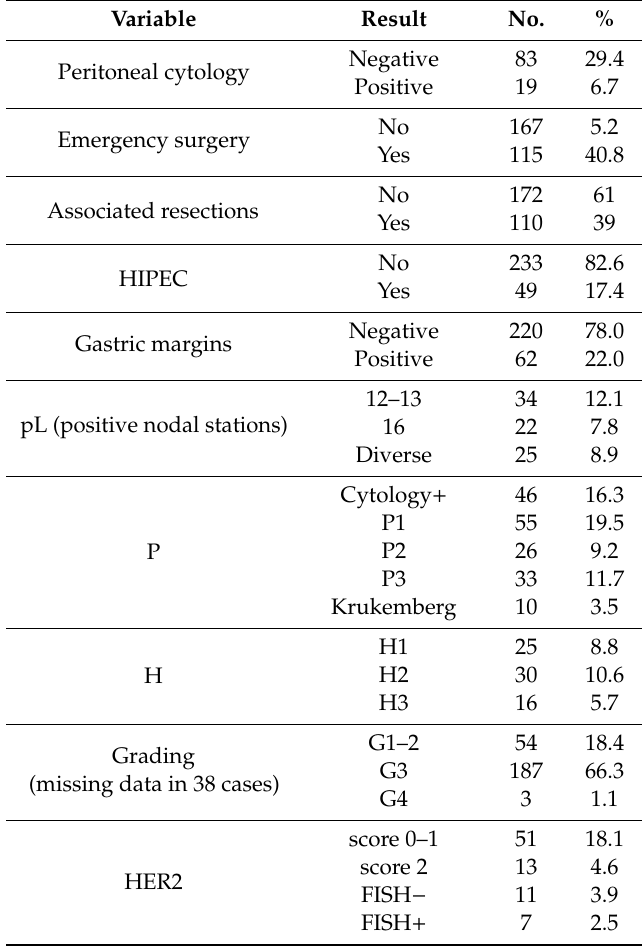
Table A1. Supplementary files: overall population characteristics. Only data not reported in other figures / tables are